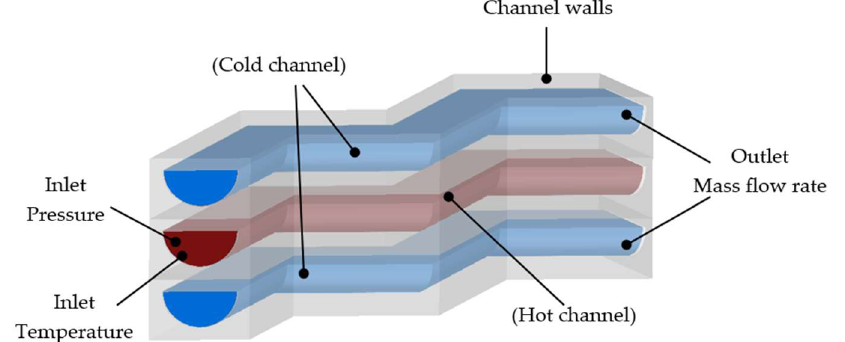
Figure 2. Boundary conditions.